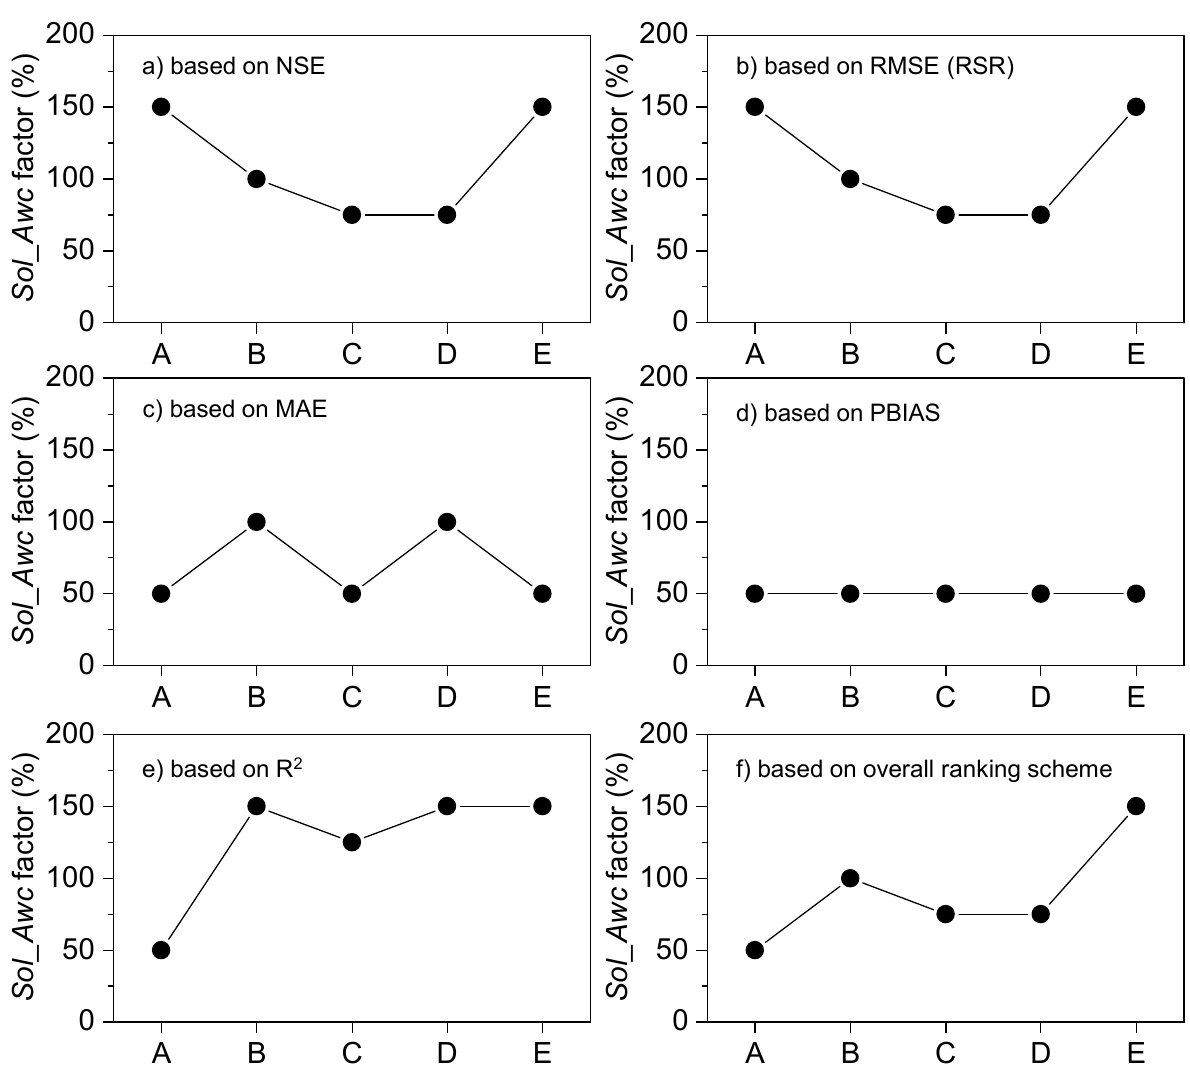
Figure 10. Decadal changes in soil available water capacity ( Sol_Awc ) factor based on ( a ) NSE, ( b ) RMSE (RSR), ( c ) MAE, ( d ) PBIAS, ( e ) R 2 , and ( f ) overall ranking scheme; Sol_Awc factor of 100% indicates the originally SWAT-assigned Sol_Awc value, which ranges from 0.16 to 0.21 mm water/mm soil.